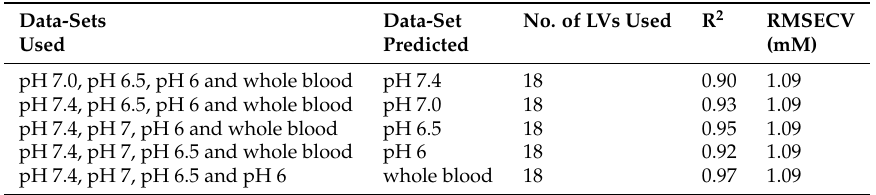
Table 4. Linear Regression results of the pH and whole blood data-sets used to build predictive models.